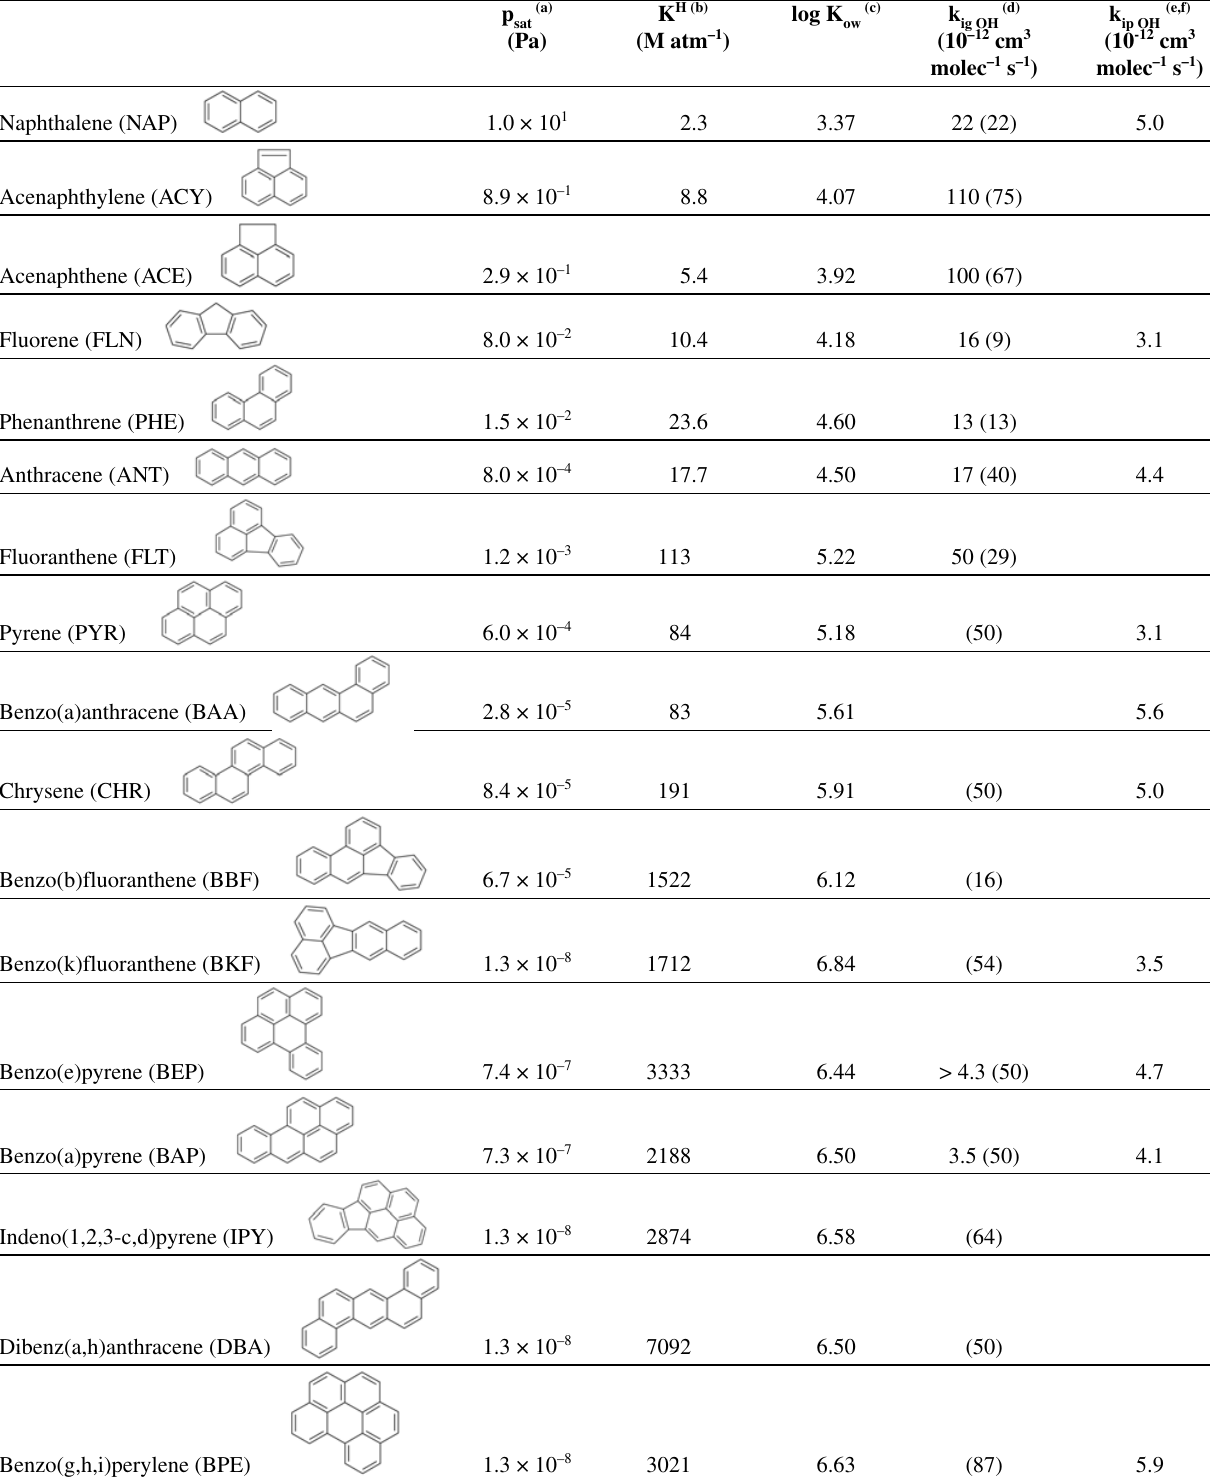
Table 1: Physico-chemical properties and degradability in air of 17 parent 2–6 ring PAHs (i.e. 16 USEPA priority PAHs and benzo(e)pyrene) at 298 K. 2, 6–7 Estimated values (EPIWIN model 8 ) in lack of experimental data are given in